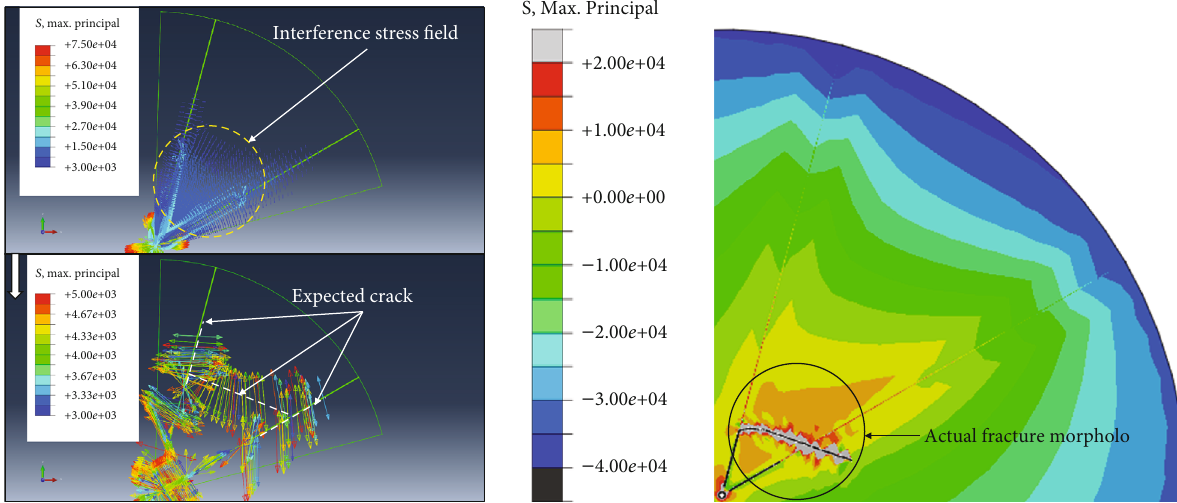
Figure 8: Fracture morphology in interference stress fi eld.